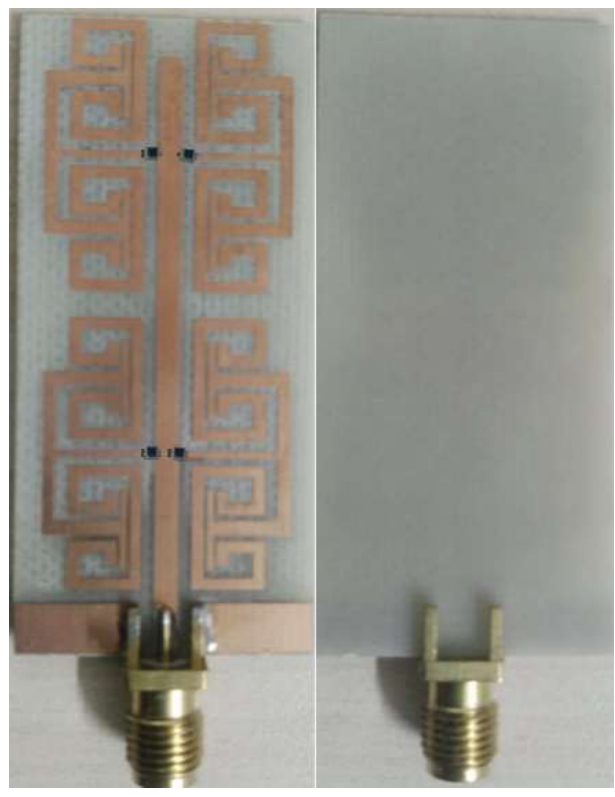
Figure 7. Fabricated prototype structure.